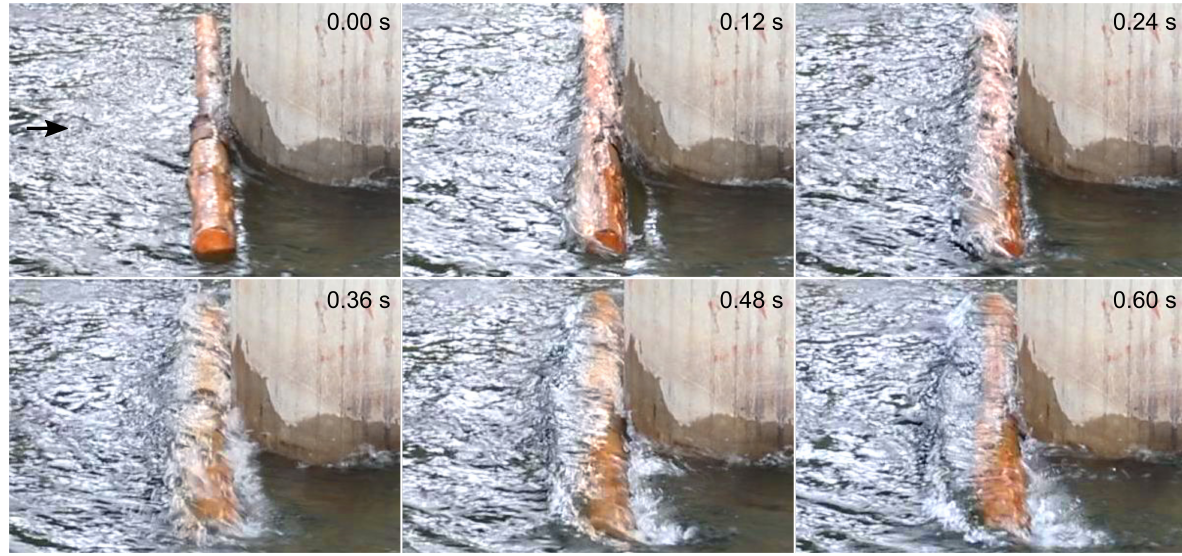
Figure 9. Snapshot series of an initial log submergence. After the log impact on the pier ( t = 0.00s), a water wave was generated and spilled over the log ( t = 0.12,0.24s) while the log changes its vertical position to a partially submerged position ( t = 0.36s and